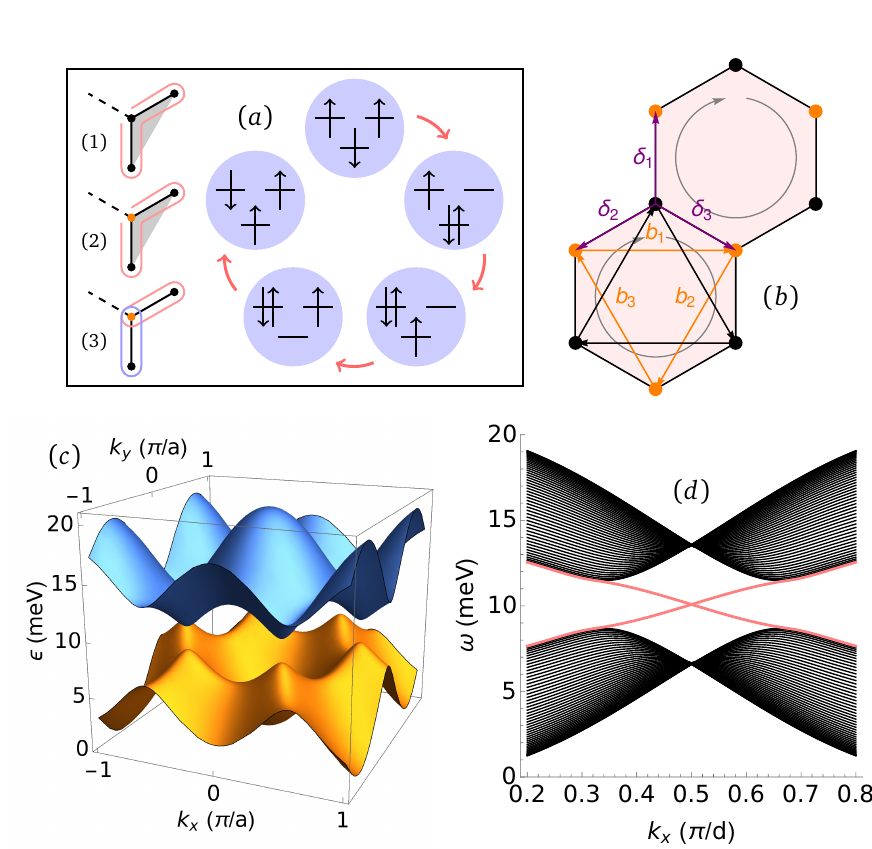
Figure 1: Chiral light-induced topology. ( a ) Illustration of the different fourth- order hopping processes available on the honeycomb lattice: ( 1 ) a process where the second intermediate state contains a holon-doublon pair at non-zero Floquet index. ( 2 ) A process where the system returns to half-filling in the second step (at the site indicated in orange) at non-zero Floquet index. ( 3 ) A process where the system returns to half-filling and zero Floquet index in the second step (at the site indicated in orange). The right panel gives an example of a process in class ( 1 ) that breaks time- reversal symmetry and induces a scalar spin chirality. ( b ) Portion of the honeycomb lattice illustrating the lattice vectors b , colored in black or orange depending on the i sublattice, and the nearest neighbor lattice vectors δ (purple). The lattice vectors i = 1) arising from hopping in a shown correspond to positive Haldane phases ( ν ik clockwise direction. ( c ) Topological magnon bands for a ferromagnetic system with S = 3 / 2, J = 2.27 meV, J (cid:48) = 0.005 meV and χ = 0.13 meV, giving a light-induced (cid:112) gap of magnitude ∆ = 6 3 χ S = 2.07 meV at the Dirac points. ( d ) Magnon bands = 100 for the same parameters as in ( c ) . The chiral for a zig-zag ribbon with n y topological edge states are indicated in